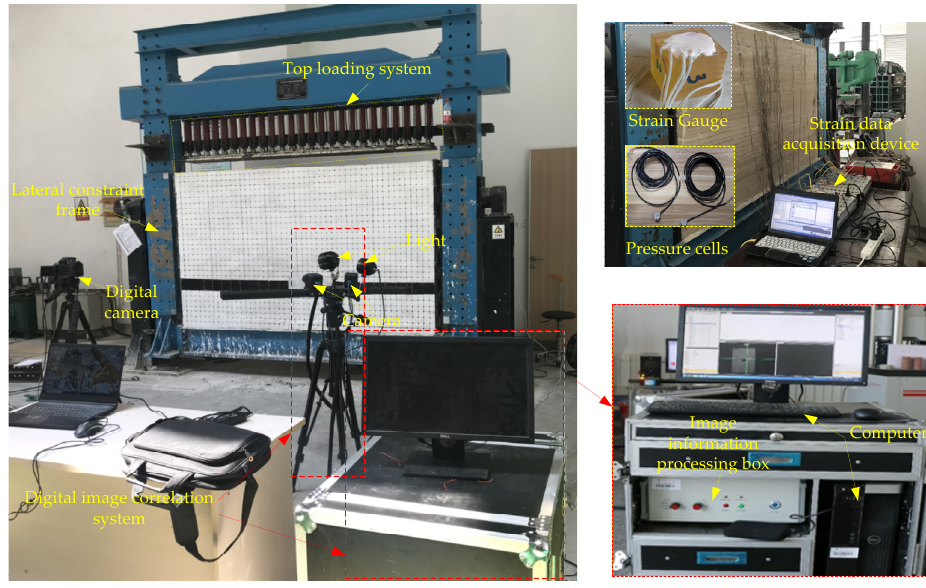
Figure 5. Test equipment and monitoring device.